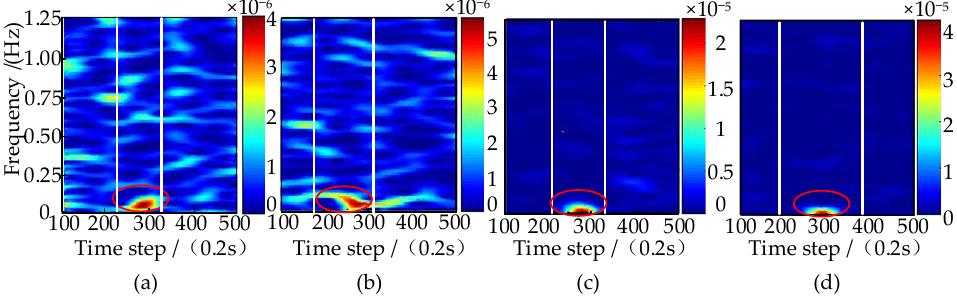
Figure 13. The time boundaries of the local region identified by the IPSE: ( a ) λ % = 10%; ( b ) λ % = 20%; ( c ) λ % = 30%; ( d ) λ % = 40%. As shown in Figure 13a, the two white vertical lines are time boundaries, and the local concentration region marked with the red circle is caused by the thruster fault. It is found that the local region is closely surrounded by time boundaries. Similarly, the local regions corresponding to percentages of thrust loss of 20%, 30%, and 40% are also closely surrounded by the time boundaries as shown in Figure 13b–d. The results indicate that the proposed IPSE has a good performance in recognizing the time boundaries of the local region. (2) Experimental validation of the STNED